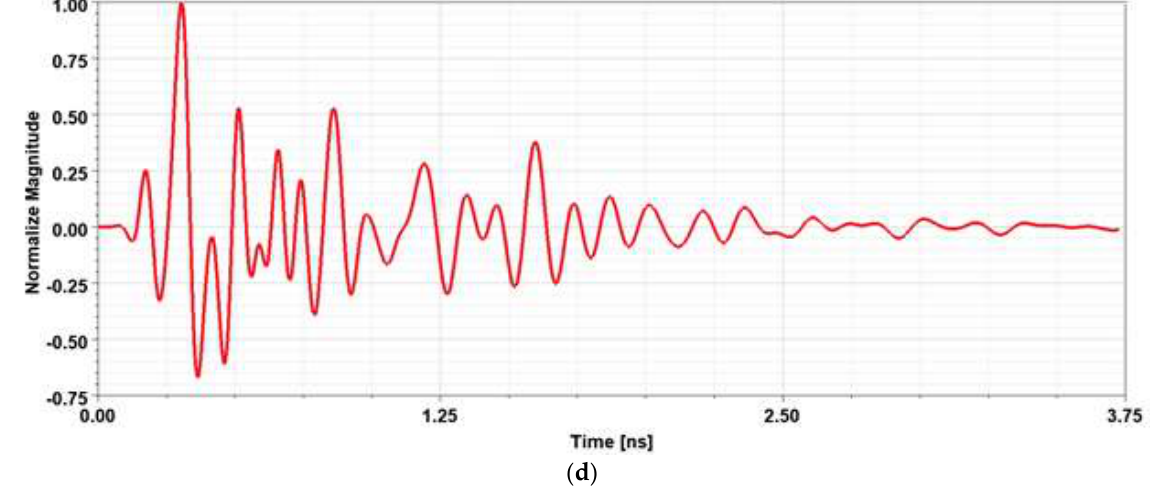
Figure 5. Time-domain results of the proposed antenna showing ( a ) input pulse, ( b ) input spectrum, ( c ) Fourier transform of the input signal, and ( d ) output signals.